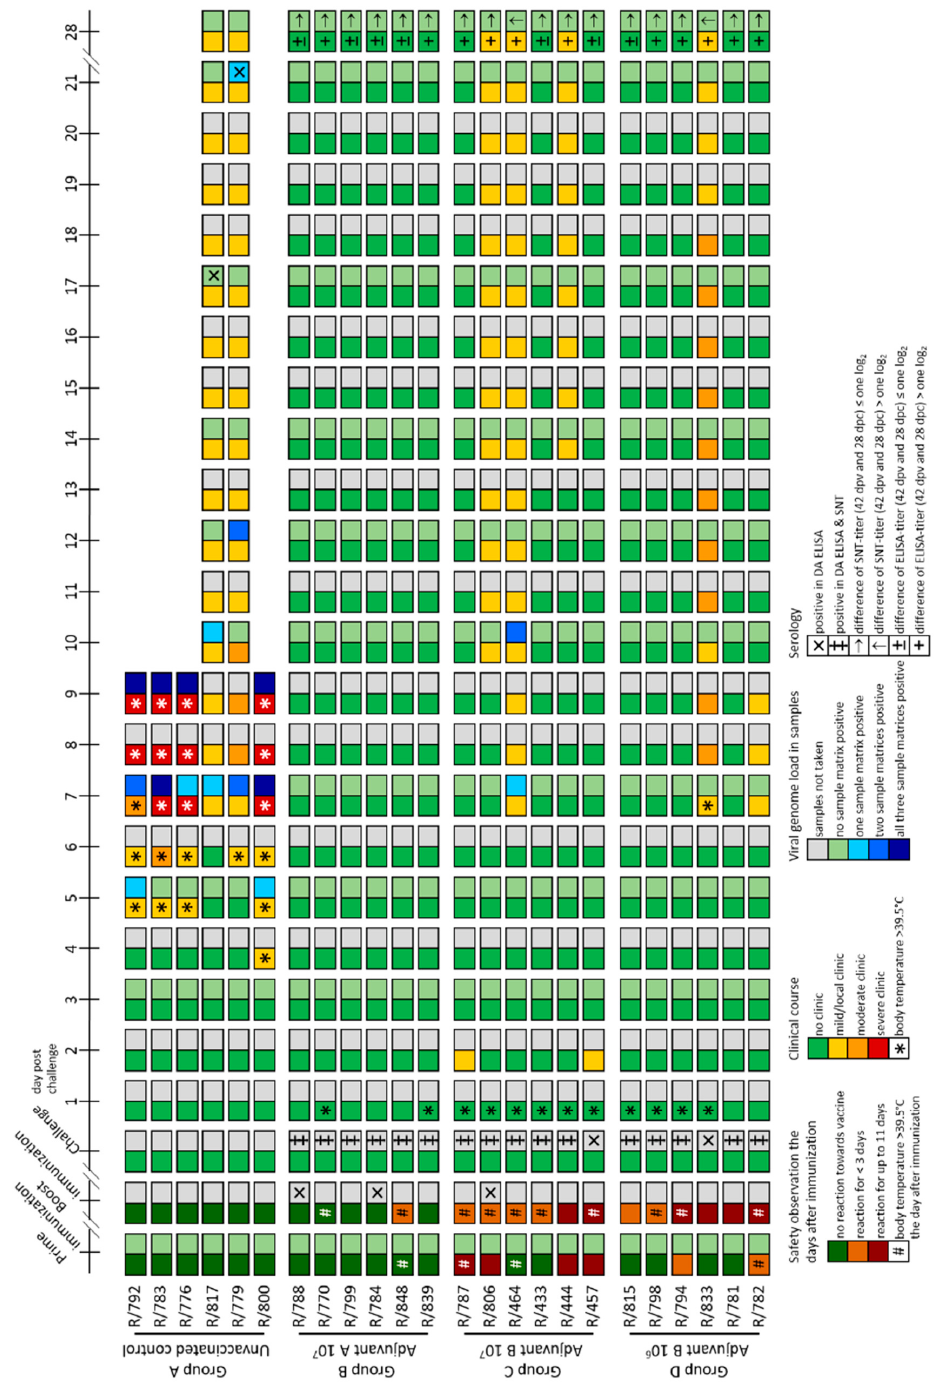
Figure 7. Summarized presentation of adverse reactions after immunization, clinical reaction, viral genome load in different samples matrices and serological examination of the vaccine-efficacy study. A rough overview of adverse reactions after immunization is shown. Furthermore, strength of clinical reaction and rise in body temperature after immunization or challenge infection are presented (left squares of each day) for each animal. Additionally, extent of viremia and shedding of viral genome as well as serological data (right squares of each day) following challenge infection are shown for each individual.